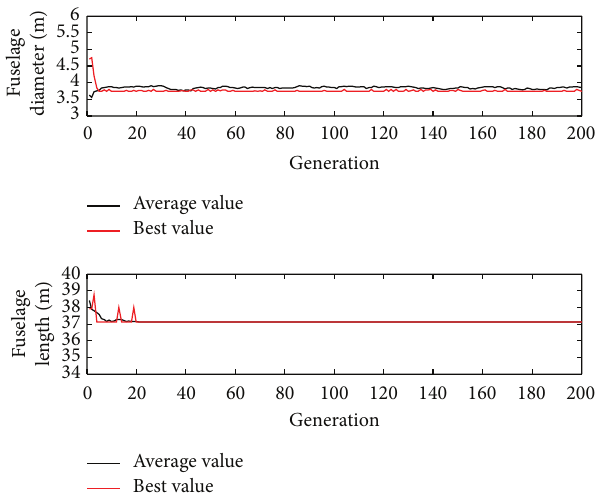
Figure 6: Best and average fuselage diameter and length (m) versus generation.